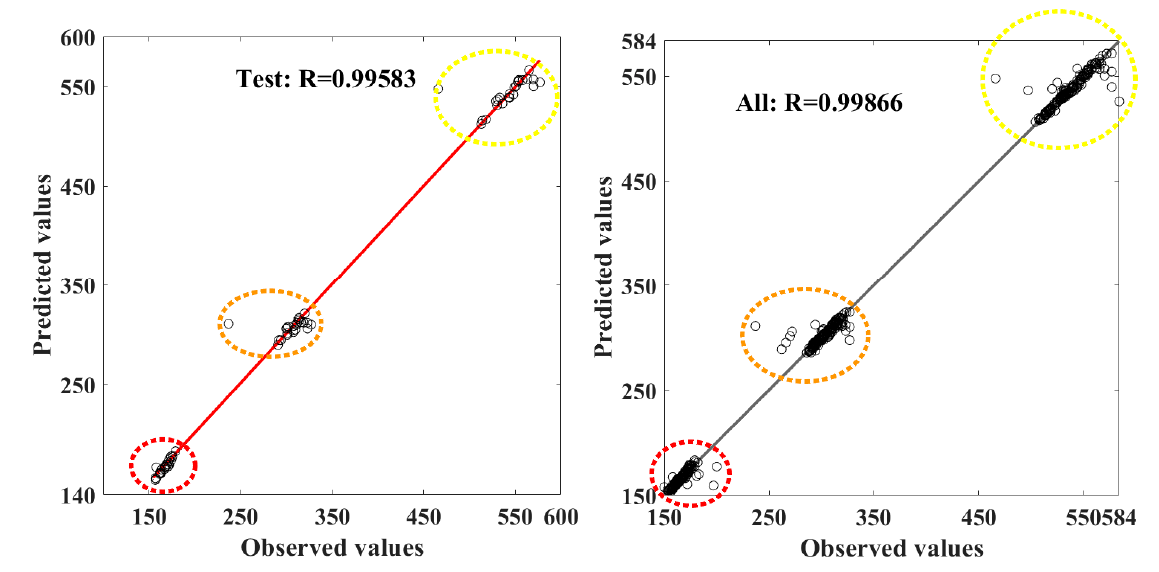
Figure 13. Correlation coefficient for three threat zone prediction values from ANN model in testing and all together in LPG plant.